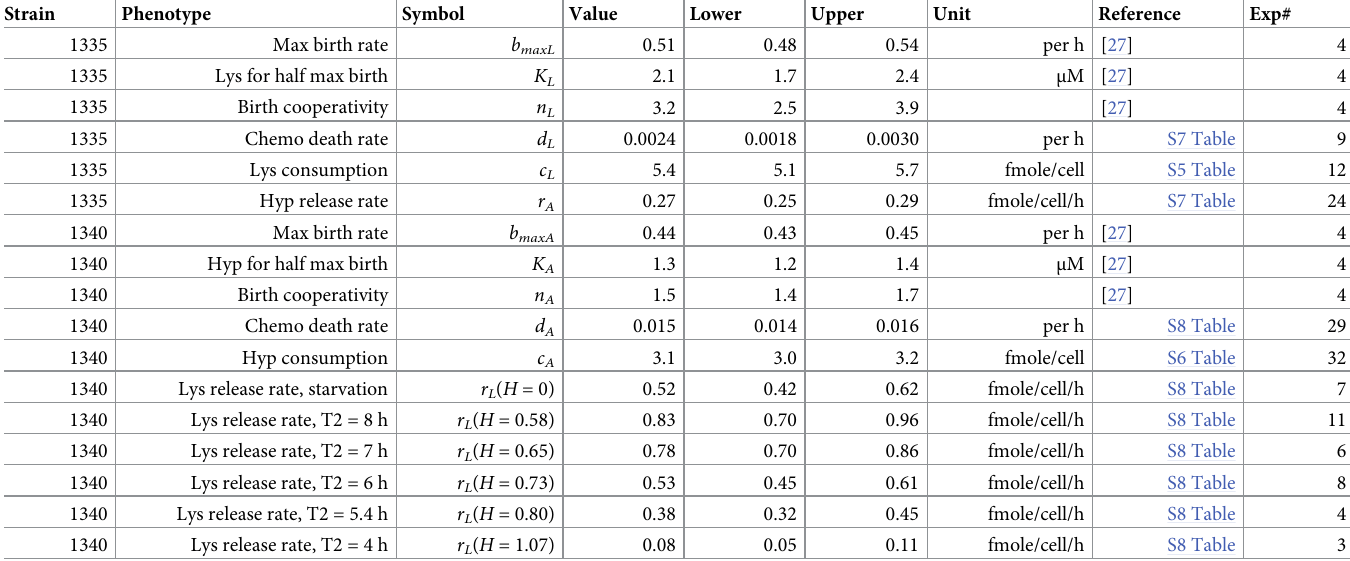
Table 1. Experimentally measured strain